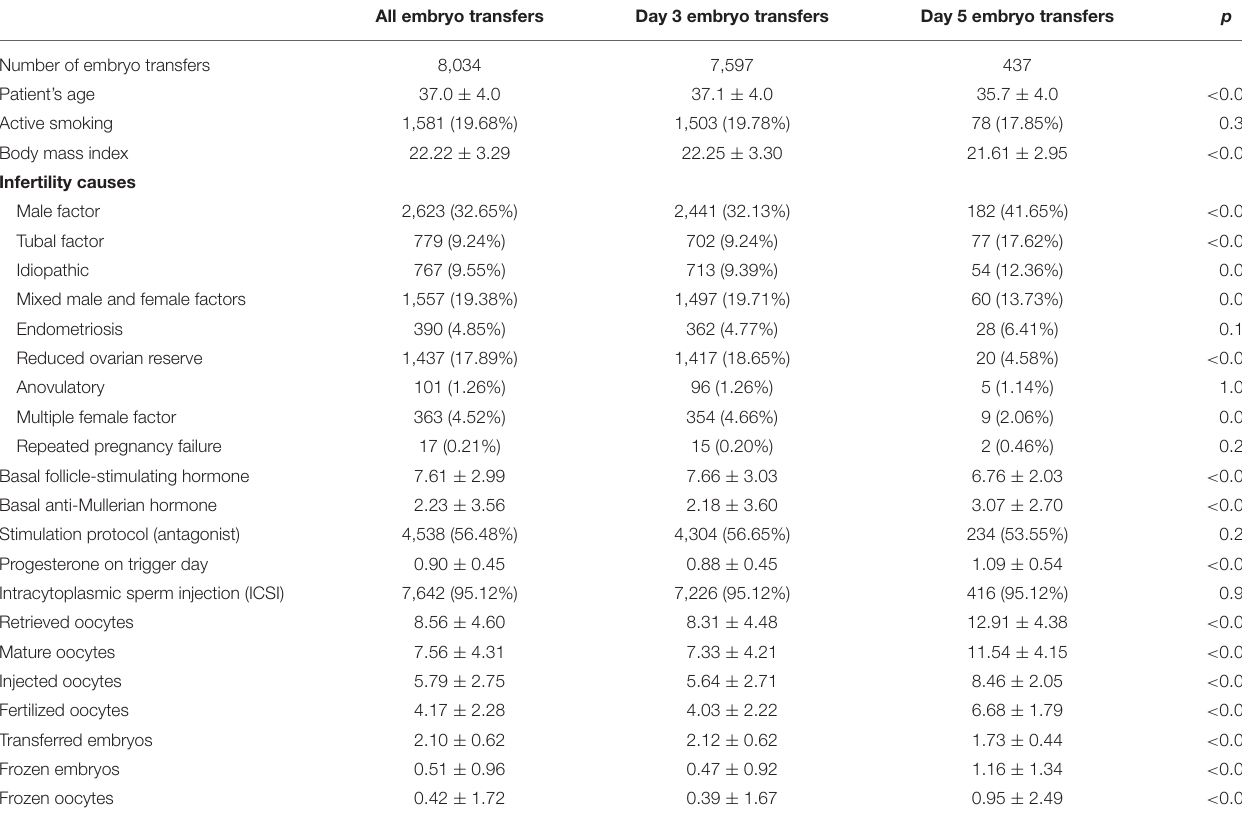
TABLE 1 | Baseline